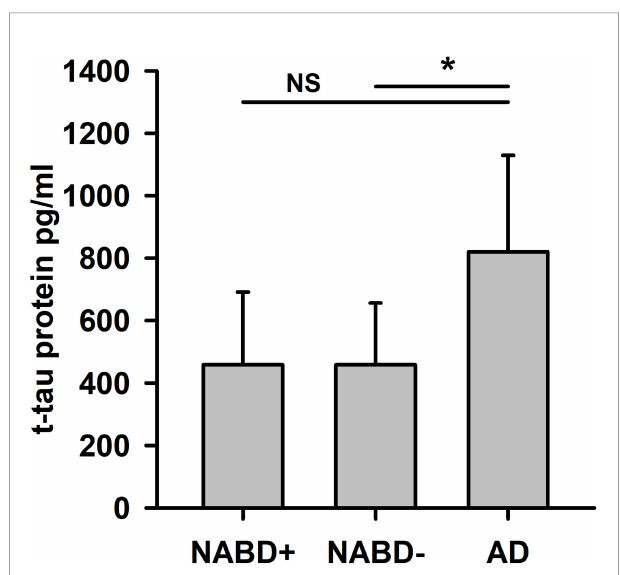
FIGURE 2 | Total tau protein is higher in AD compared to patients with neural-associated dementia. Total tau protein (t-tau protein) in cerebrospinal fl uid (CSF) is signi fi cantly different in NABD − versus AD, but not in NABD+ versus AD patients. AD, Alzheimer ’ s dementia; NABD+, neural autoantibody- associated dementia including patients with CSF-based Alzheimer ’ s CSF- based Alzheimer ’ s disease pathology; NABD − , anti-neural autoantibody associated dementia without CSF-based Alzheimer ’ s disease pathology; CSF, cerebrospinal fl uid. *p < 0.005. NS, non-signi fi